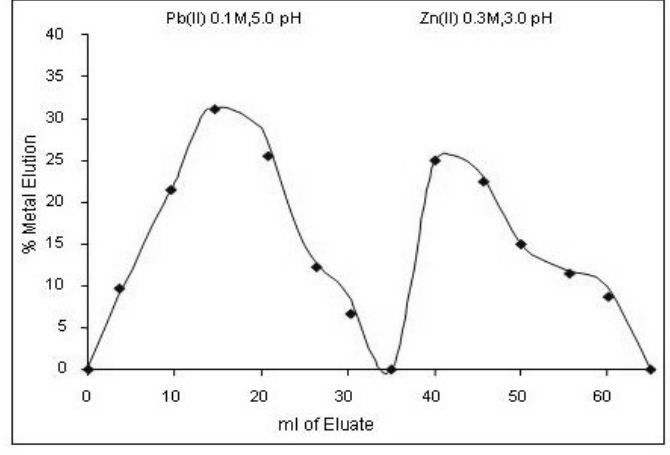
Figure 7 . Separation of Pb(II) and Zn(II) on AFM resin